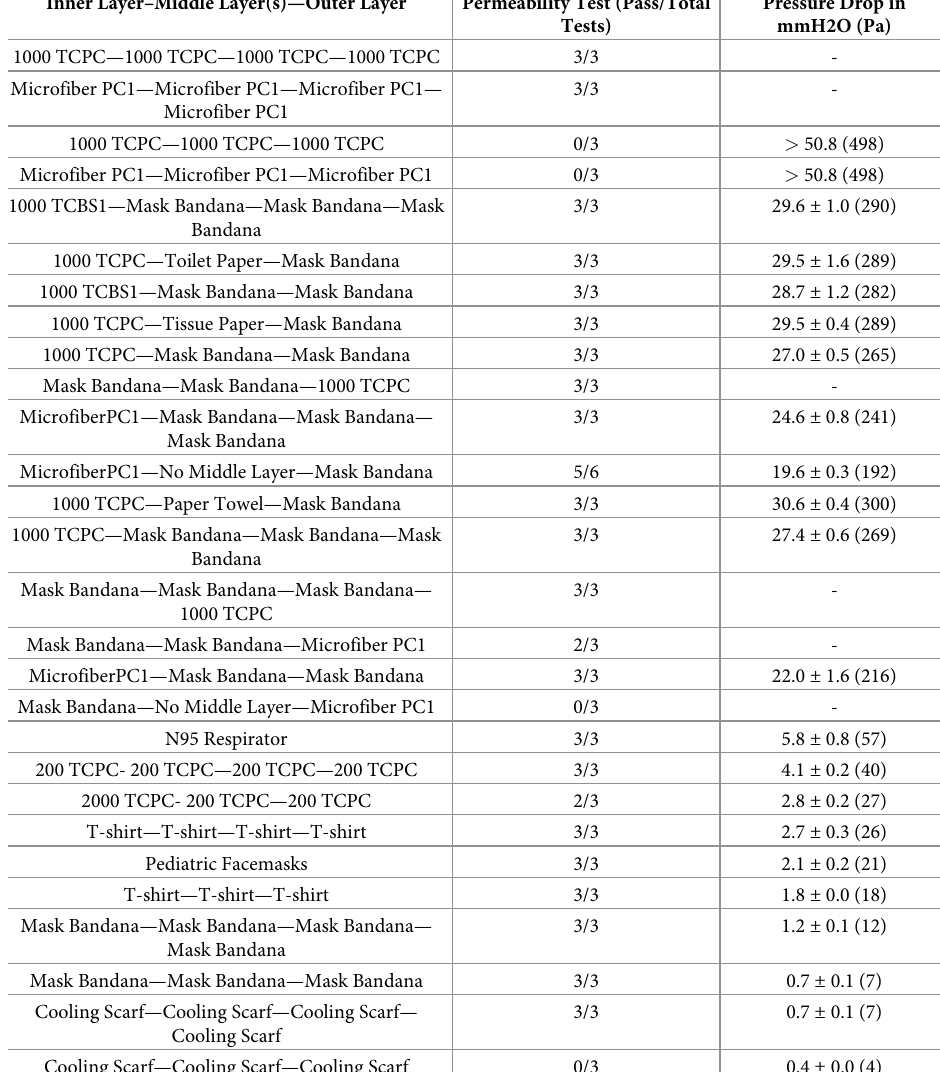
Table 2. Layers of materials, or combination materials, from wearer side to the outside, rate of passing the perme- ability test, and the corresponding pressure drop. Inner Layer–Middle Layer(s)—Outer